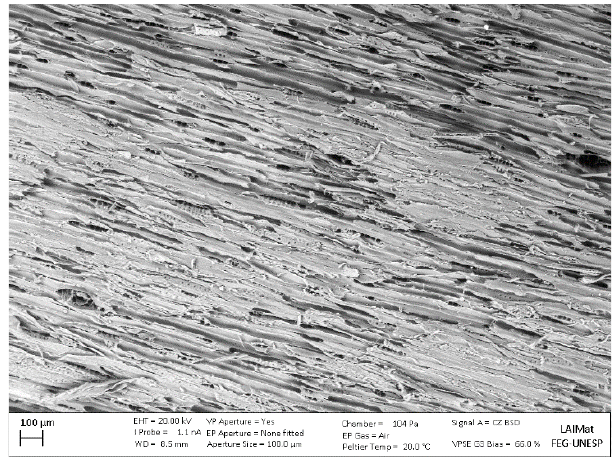
Figure 4. SEM image of veneer surface treated at 160 °C.